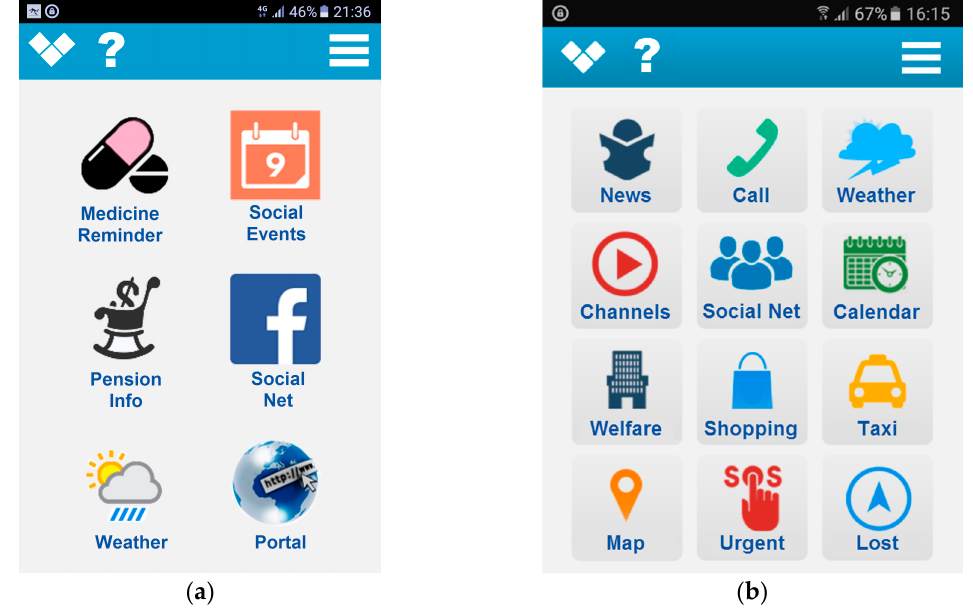
Figure 4. Service-centric views of Senior App Suite with ( a ) basic features and ( b ) more rich features.